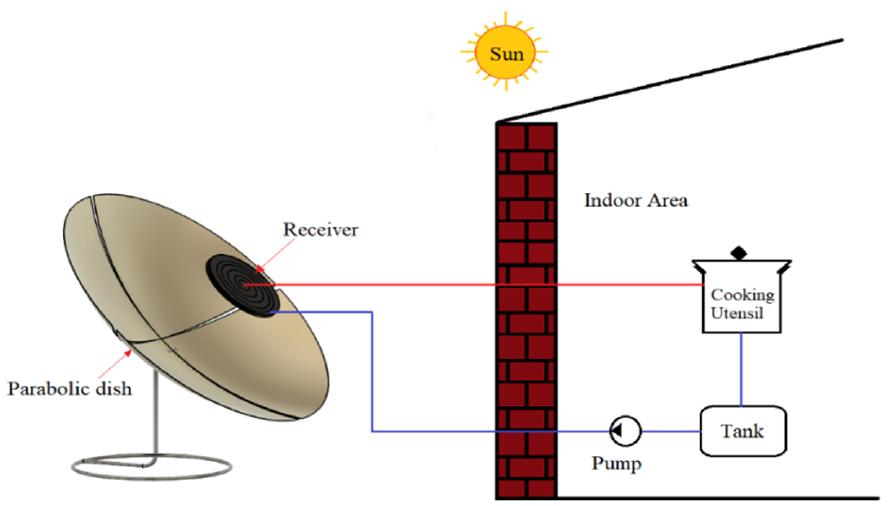
Figure 3. An indoor cooking system with a parabolic dish collector. Reprinted/adapted with permission from (2021) Hosseinzadeh et al. [29].